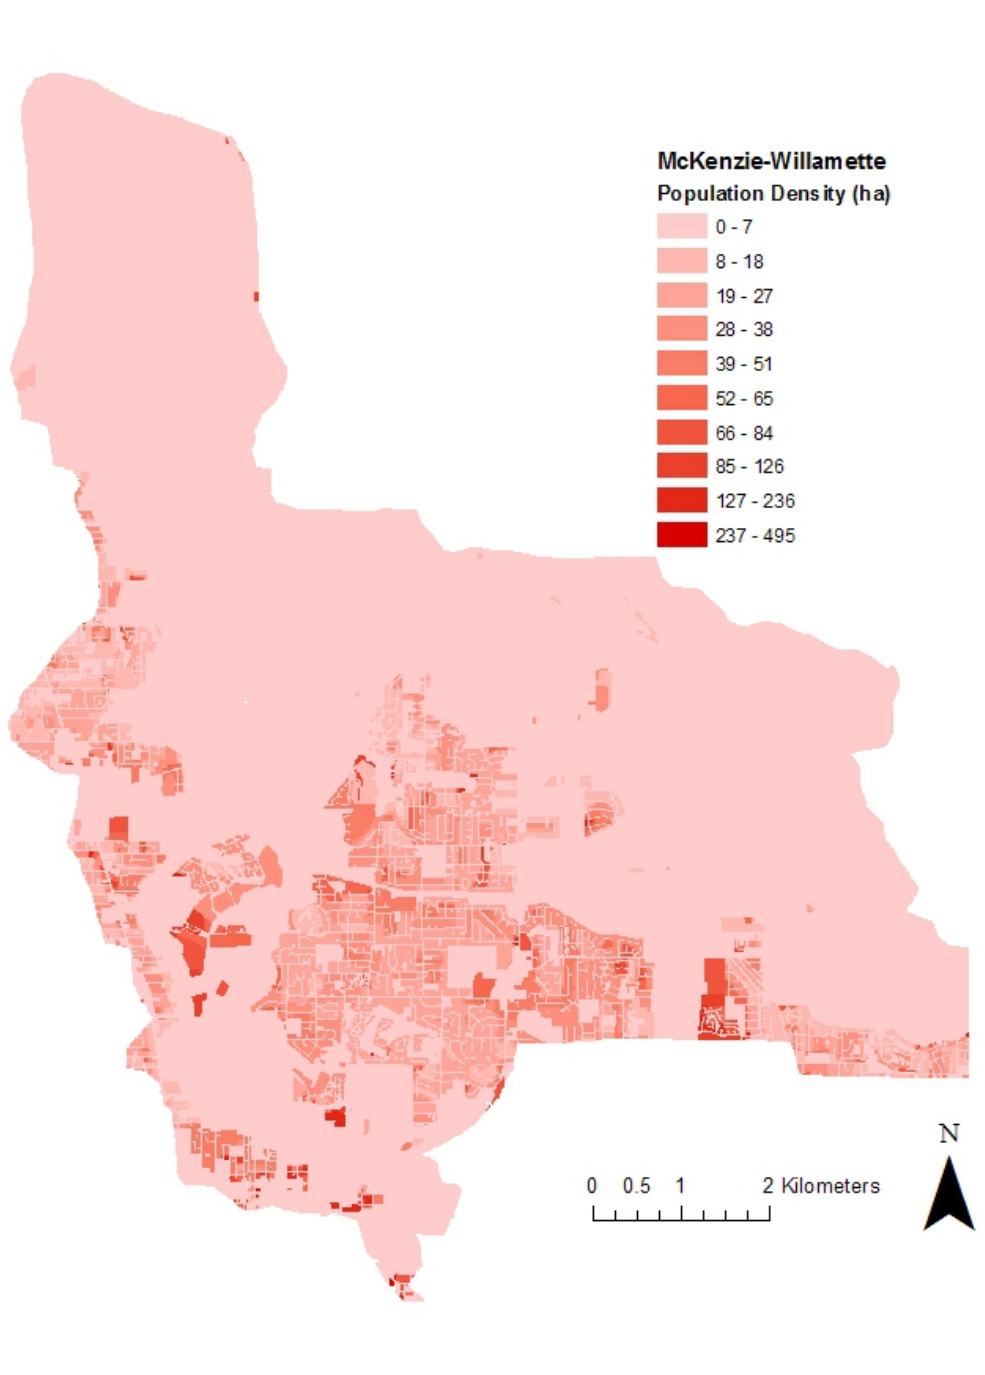
Fig. 8 . Initial population densities in the study area are shown with darker shades representing higher densities. The ranges are given in